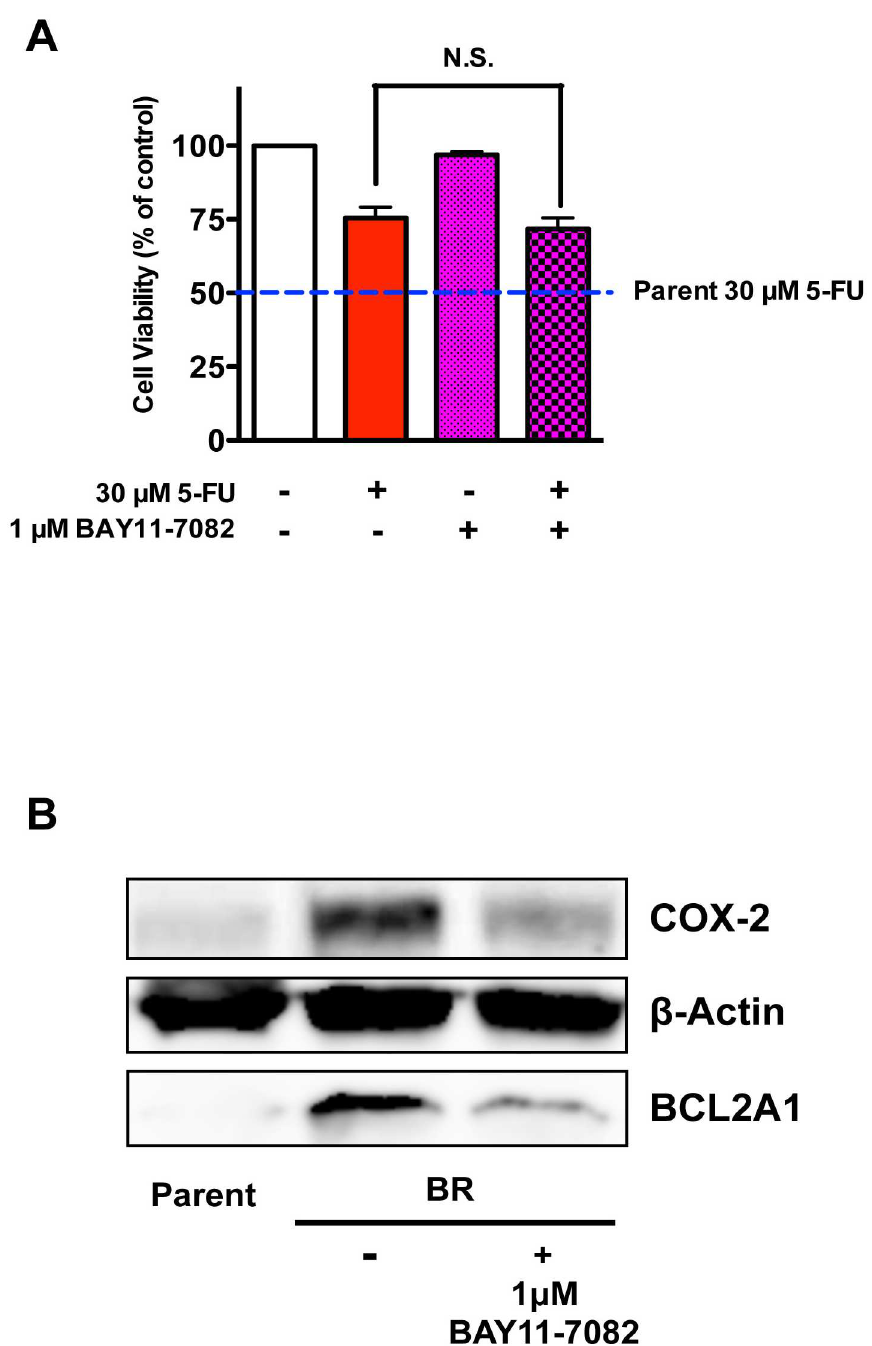
Fig 5. Effect of BAY11-7082 on MDA-MB-231BR as an NF- κ B inhibitor. (A) Cytotoxicity of 5-FU to MDA-MB-231BR in the presence of 1 μ M BAY11-7082. Blue broken lines parallelto x-axis represent the cell viabilityof MDA-MB-231 (Parent) treated with 30 μ M 5-FU. Data represent the mean with SEM of four independent samples. (B) Changesin protein expressions of COX-2 and BCL2A1 in MDA-MB-231BR in response to 1 μ M